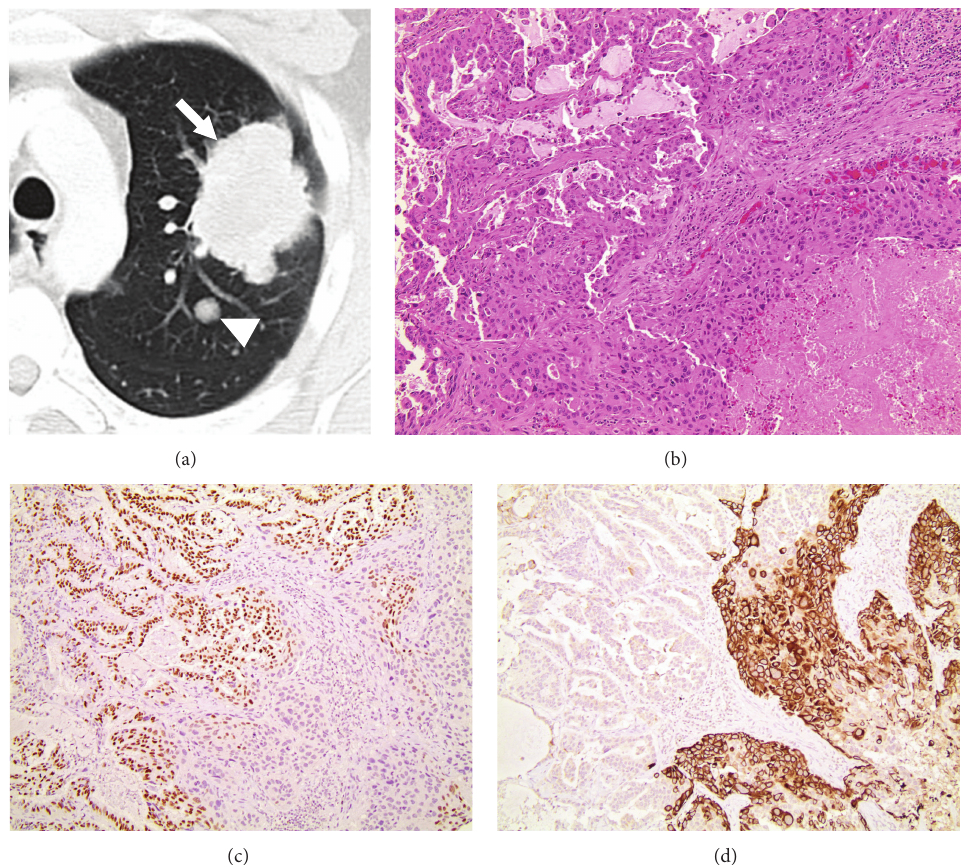
Figure1:Radiologicandhistologicfeaturesoflungcanceratinitialpresentation.(a)ContrastenhancedaxialCTimageshowsa6 cmlobulated left upper lobe mass (arrow) with irregular margins and pleural tags and a 1cm satellite left upper lobe nodule (arrowhead). Histological examination shows (b) adenosquamous carcinoma with two distinct tumor components including (c) adenocarcinoma, immunoreactive with thyroid transcription factor-1 and (d) squamous cell carcinoma, immunoreactive with keratin